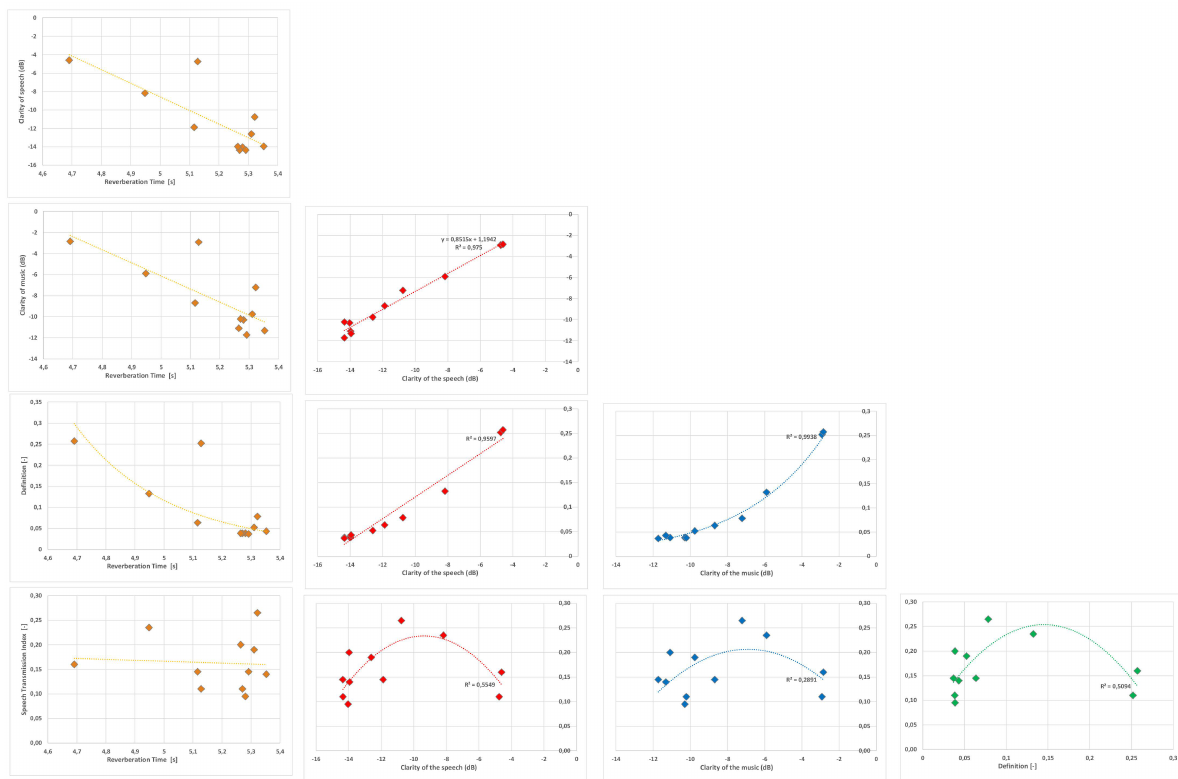
Figure 16. The best fit correlation among different acoustic parameters.